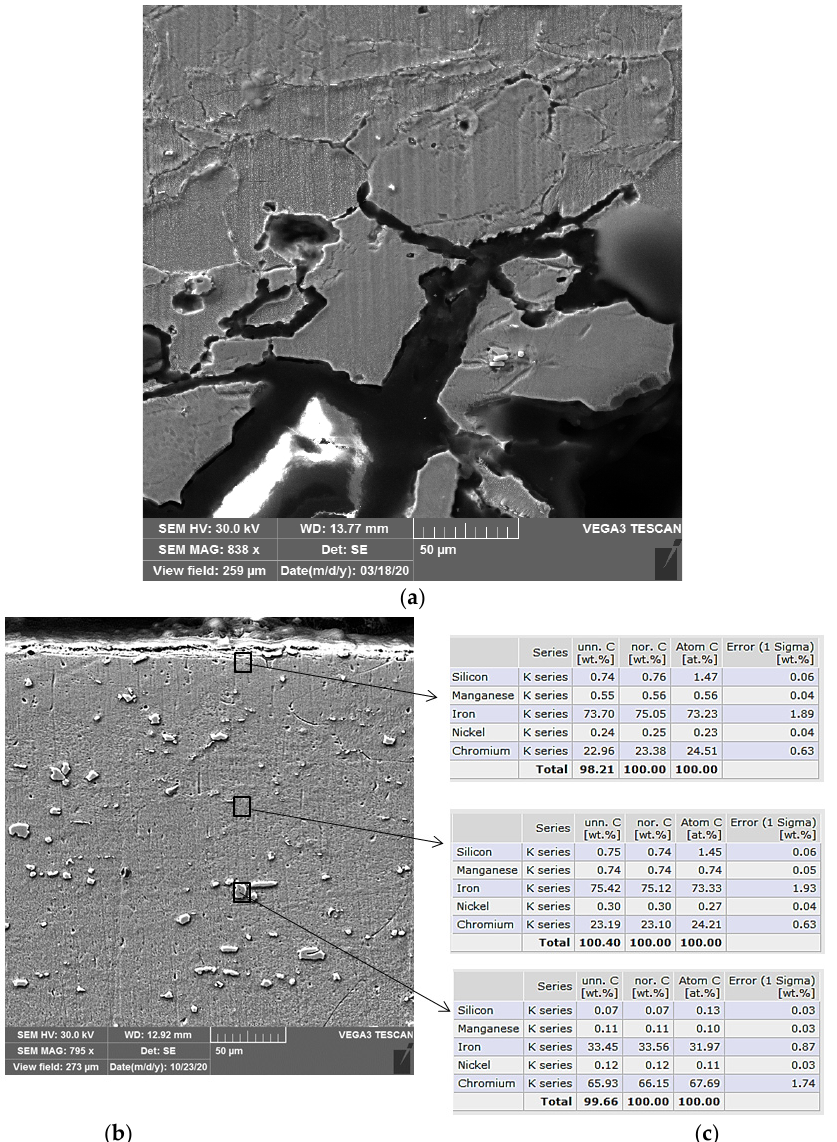
Figure 5. SEM microstructure of a section through the corroded ( a ) AISI 442 steel sample, ( b ) AISI 446 sample and ( c ) corresponding EDX